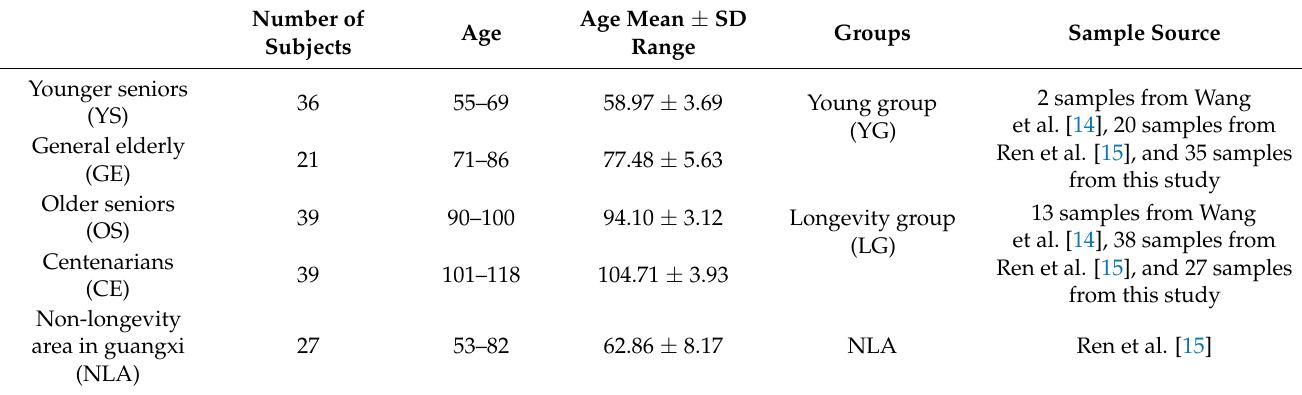
Table 1. Basic information and grouping of